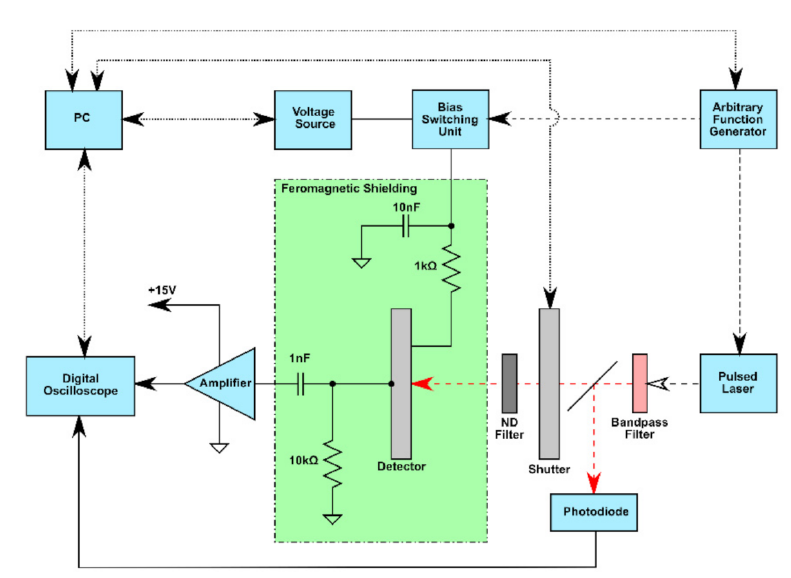
Figure 4. Laser-induced transient current technique (L-TCT) measurement